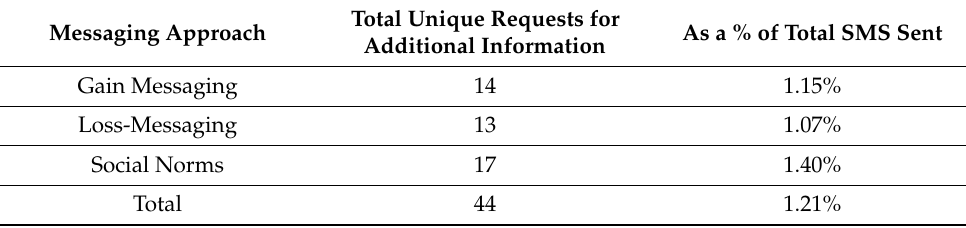
Table 2. Distribution of participants in the SMS group that requested additional